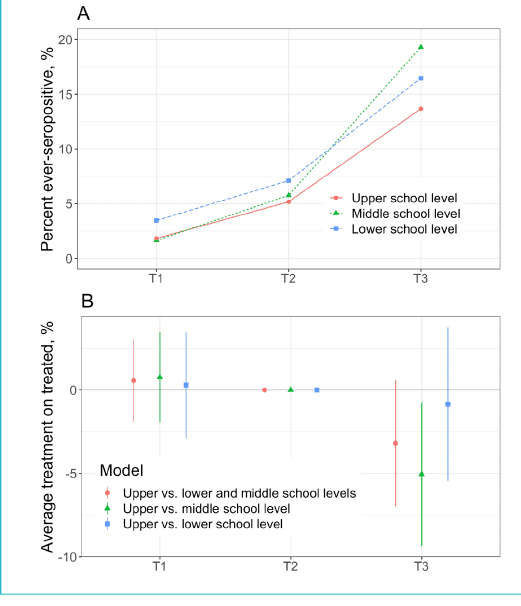
Figure 3: Difference-in-differences model of the change in ever- seroprevalence between T2 and T3 in upper school level. A – Raw proportion of children, included in the models, ever testing seropositive by T1, T2 and T3 time points B – Difference-in-differ- ences estimates of linear probability models, with T2 as the refer- ence. The parallel trends assumption is valid, as the estimates at T1 are not different from the T2 reference. Average treatment (ef- fect) on the treated denotes the change in seroprevalence, poten- tially attributable to the effect of mask wearing by upper school lev- el children.